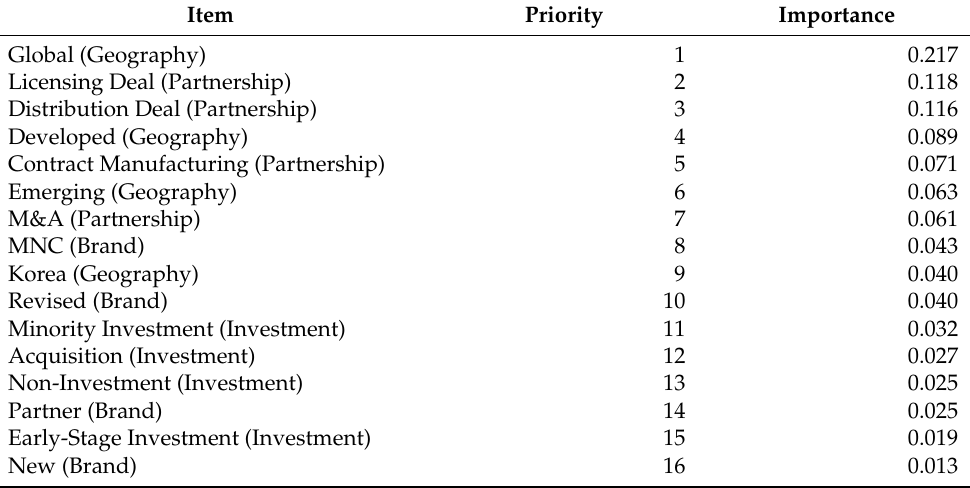
Table 8. Results of external conditions (deal